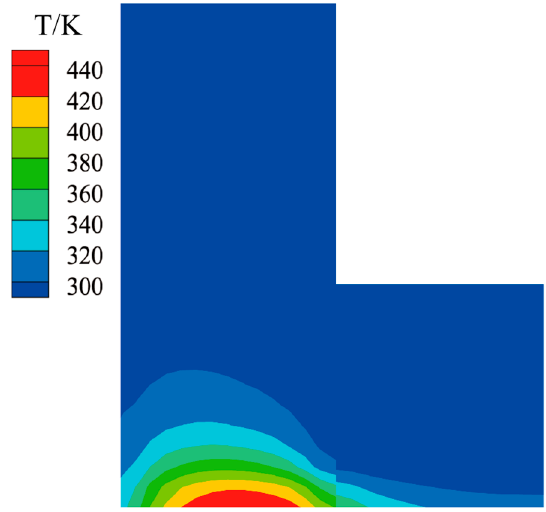
Figure 9. Temperature distribution of bristles.